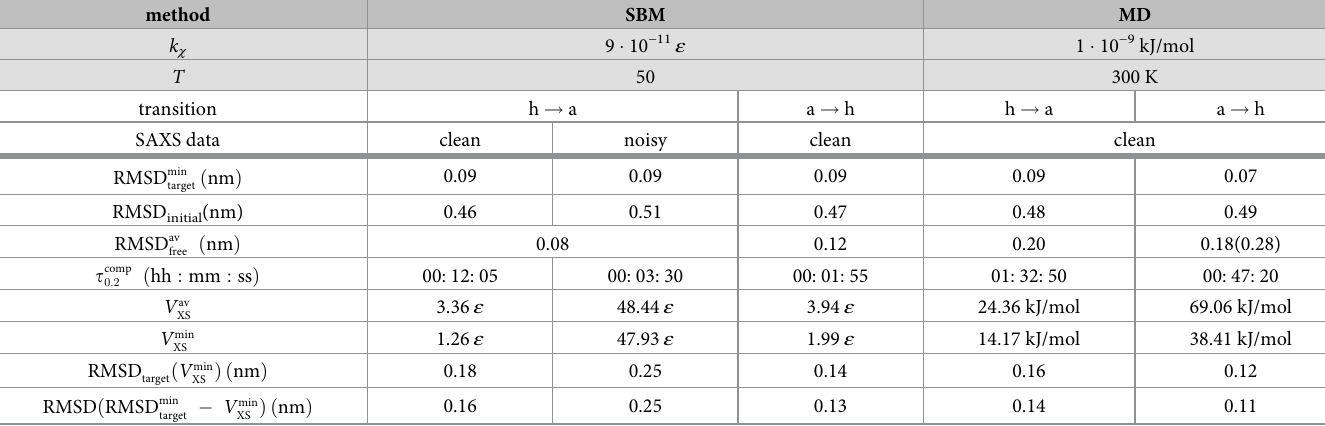
), associated initial RMSD (RMSD initial ), target ), average bias 0 : 2